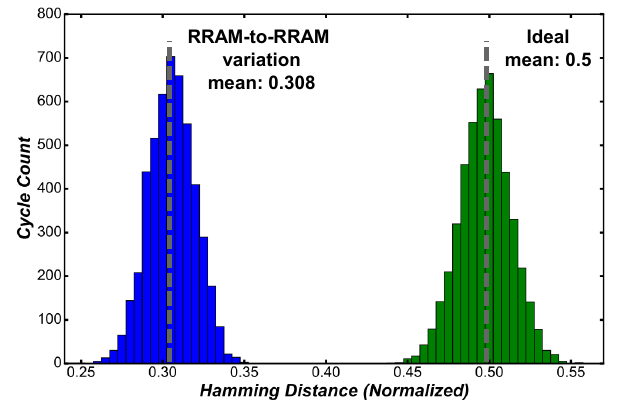
Figure 23: The simulated inter-configuration hamming distance with and without the RRAM-to-RRAM variation using the parallel SET